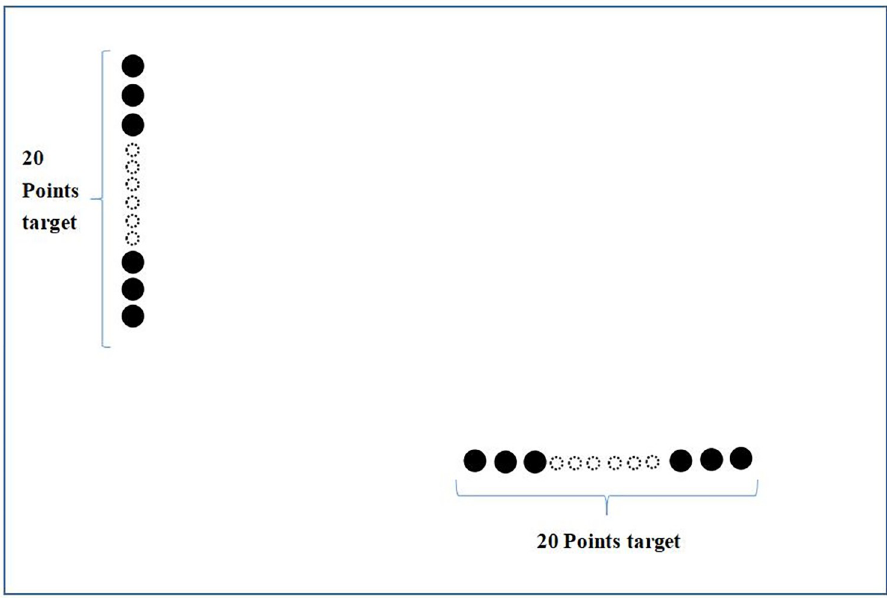
Fig 3. Schematic diagram of point